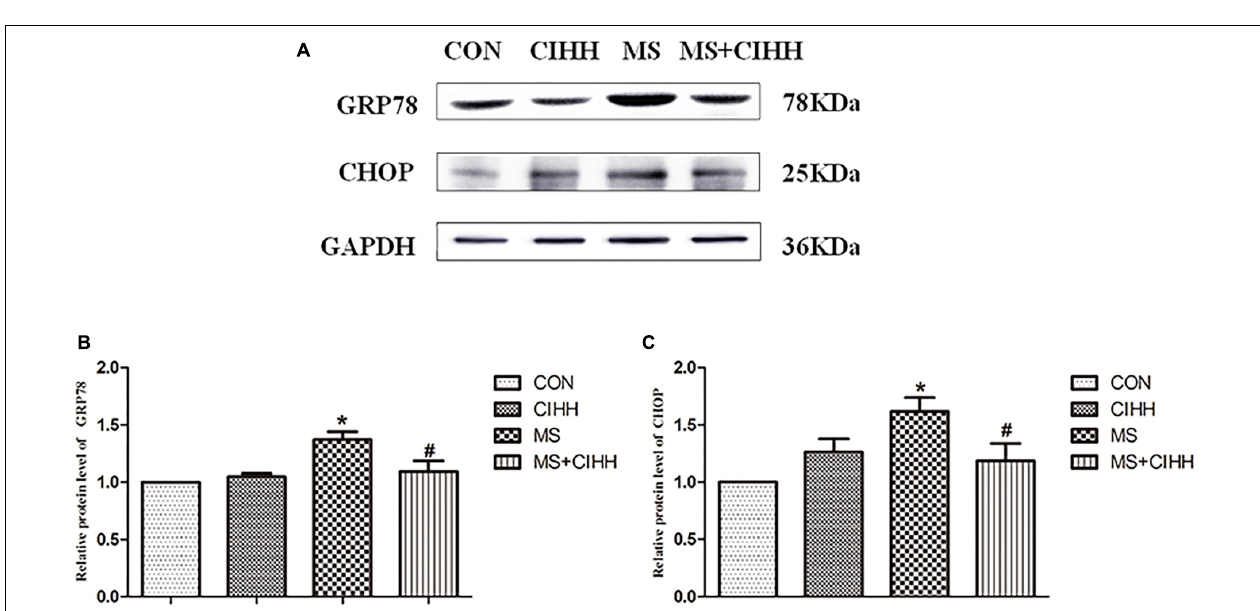
FIGURE 5 | Effect of CIHH on the expression of ERS-related proteins in rat livers. (A) Original recording of Western blotting. (B) Quantification of protein levels of GRP78. (C) Quantification of protein levels of CHOP. CON: control group, CIHH: CIHH group, MS: metabolic syndrome group, MS + CIHH: MS + CIHH group. All data were expressed as mean ± SD; n = 4 for each group. * P < 0.05 vs. CON, # P < 0.05 vs. MS.